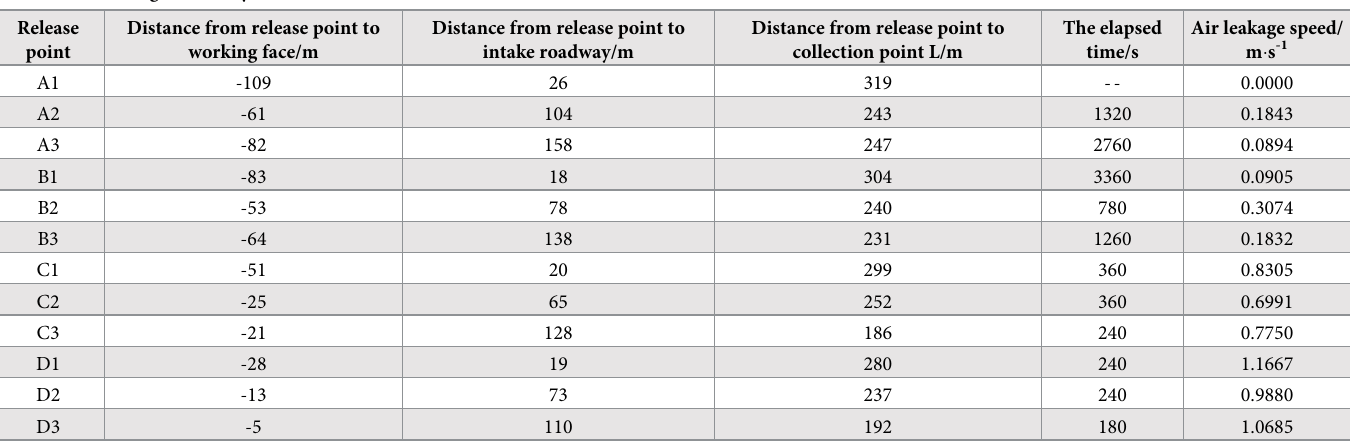
Table 1. Air leakage test analysis.